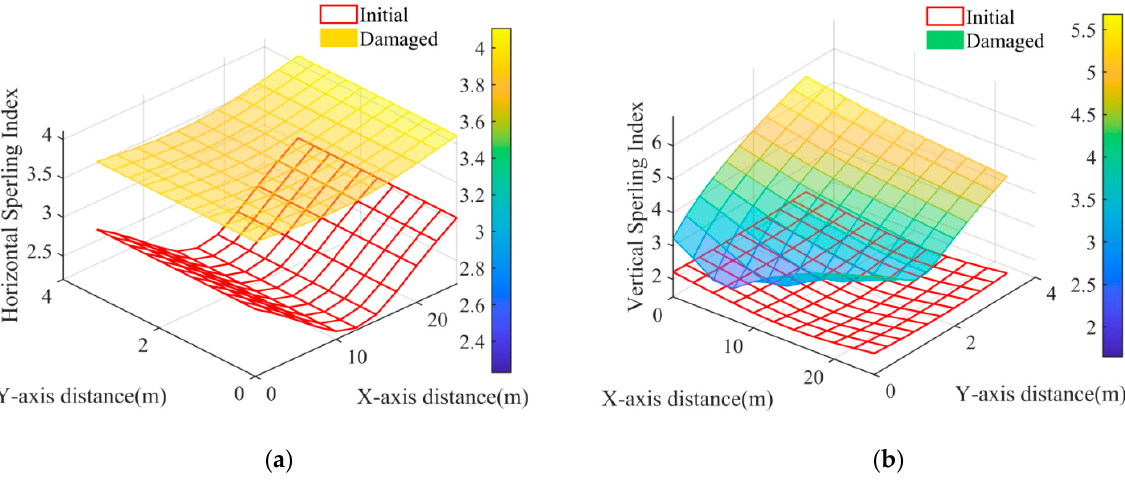
Figure 10. Zonal distribution of Car-Body Sperling index influenced by the damage of a vertical spring damper in secondary suspension system using PEM: ( a ) horizontal Sperling index; ( b ) vertical Sperling